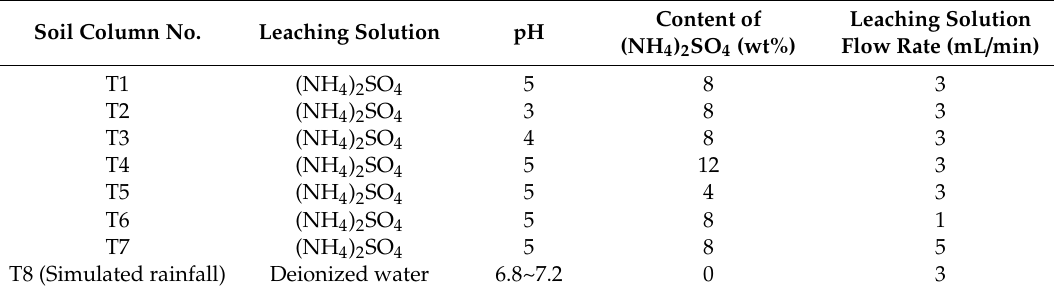
Table 1. Experimental parameters of simulated